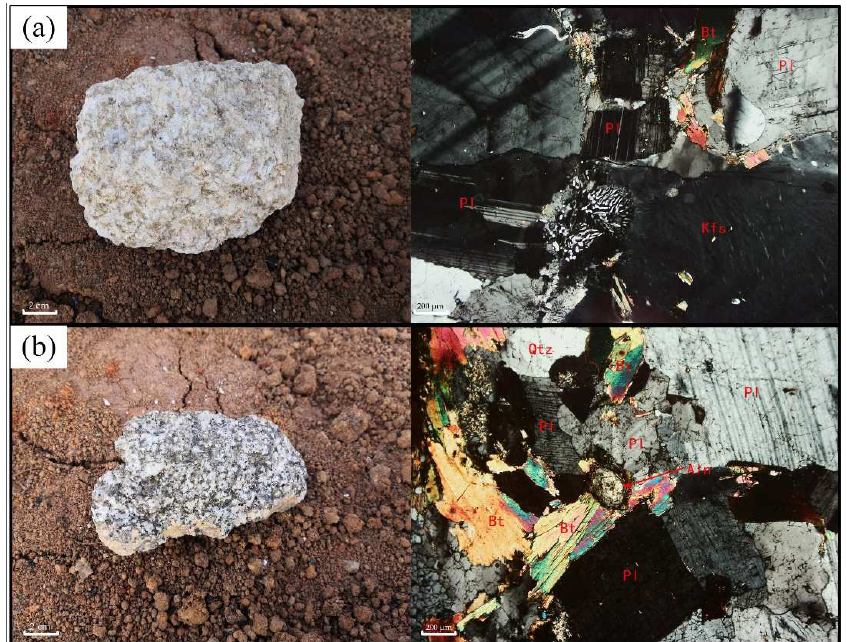
Figure 3. Result of thin section identification. The result indicates the following mineral components: plagioclase (PI), K-feldspar (Kfs), biotite (Bt), quartz (Qtz) and epidote (Aln). ( a ) Rock sample LH42 (from Cretaceous). ( b ) Rock sample LH61 (from Jurassic).